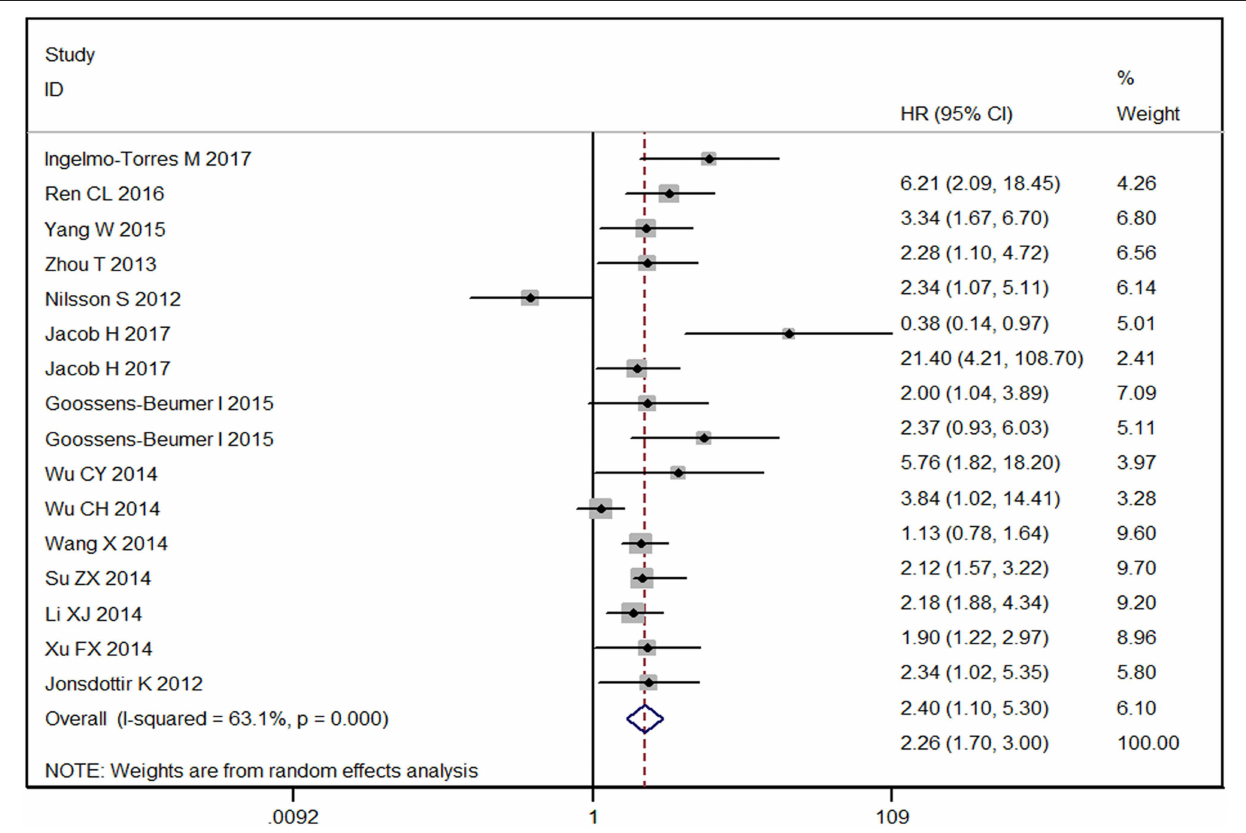
Frontiers in Molecular Biosciences |